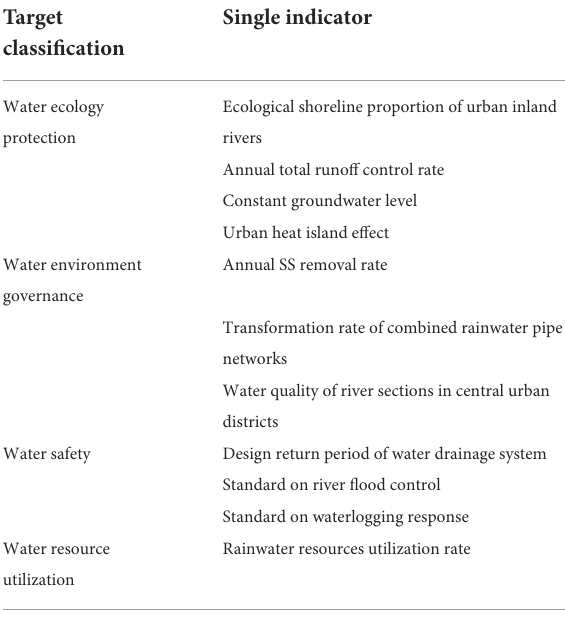
TABLE 2 Target indicator system based on the “four-water theory”